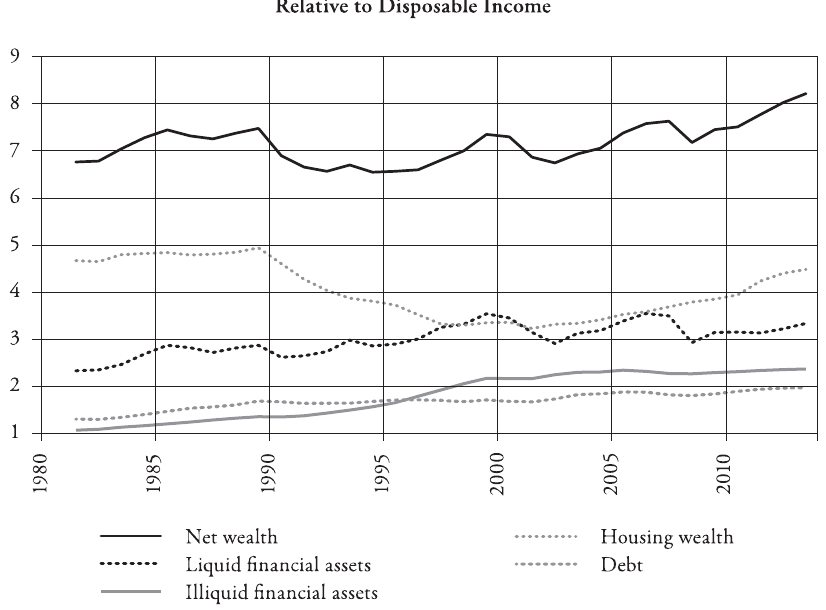
Figure 5: Components of Swiss Household Wealth Relative to Disposable